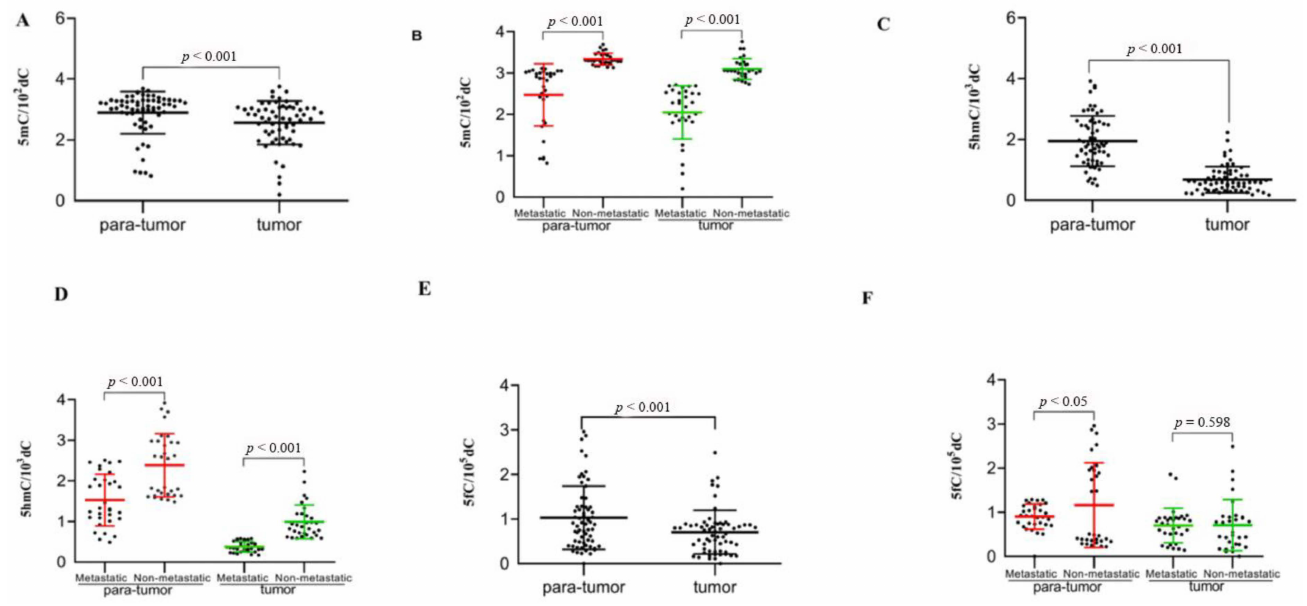
Figure 1. The 5mC, 5fC and 5hmC levels of global genome reduced in SHCC. Genome-wide DNA extraction was made in SHCC and corresponding healthy samples among 63 cases and used for 5mC, 5fC and 5hmC UHPLC-MS/MS observation. The 5mC ( A ), 5hmC ( C ), 5fC ( E ) levels in every sample have been given. The 5mC, 5fC and 5hmC levels obviously declined within metastasis SHCC tissues in comparison with para-tumor tissues ( A , C , E ). Obvious changes in 5hmC and 5mC levels were observed in SHCC and normal samples during metastasis ( B , D ). The 5fC contents during metastasis in SHCC para-tumor tissues continually decreased obviously in comparison with non-metastasis. No remarkable distinctions were observed from SHCC tissues ( F ). p -value from statistical analysis comparing different groups is also